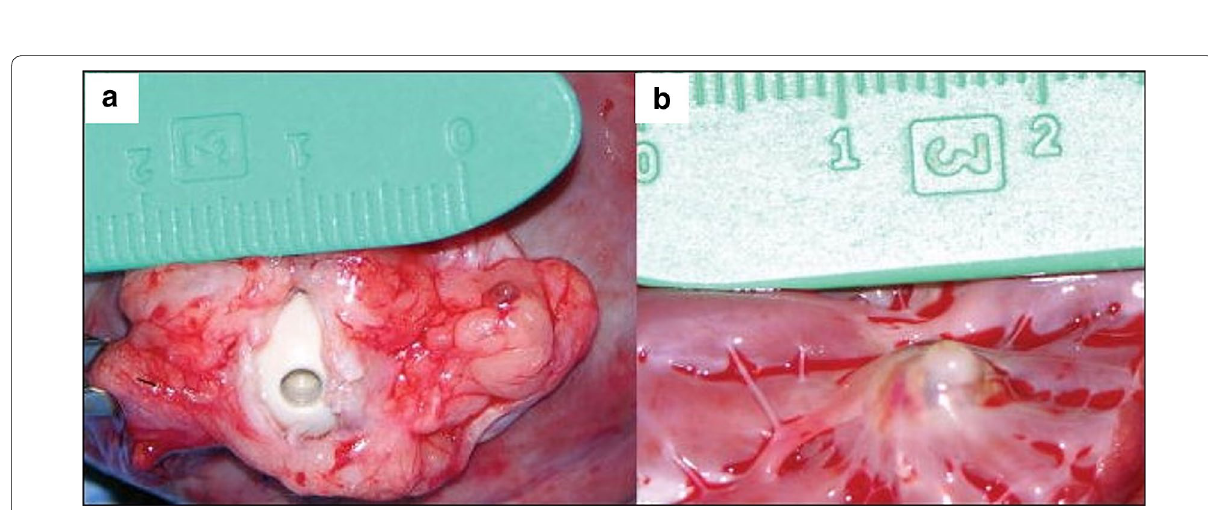
Fig. 9 a Pictures of devices implanted in the left ventricular apex. b Implant site (Reproduced with permission from Ref. [53], Copyright © 2012 by the American Society for Artificial Internal